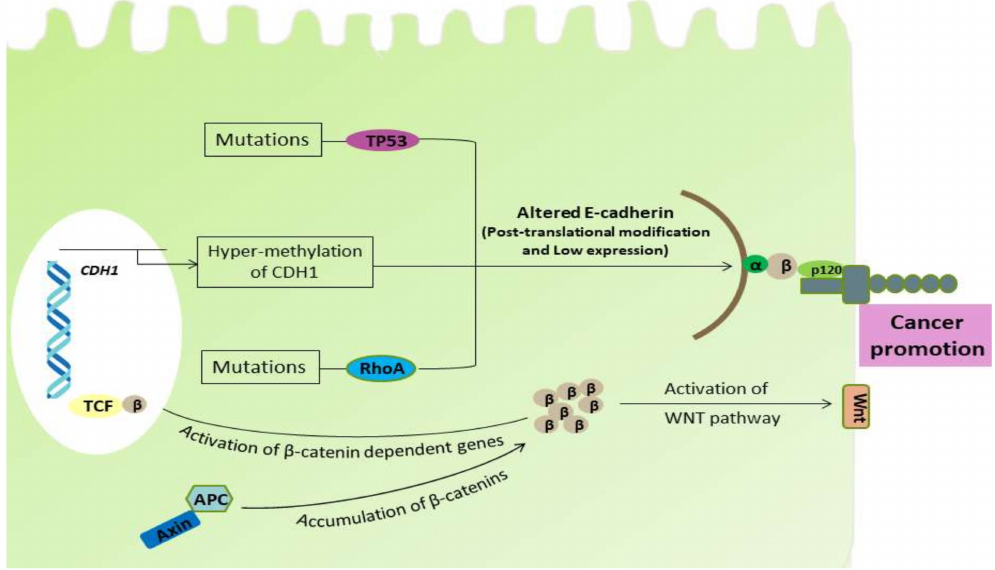
Figure 2. Pathogenicity and factors associated with the disruption of the normal cellular activity. Hyper-methylation of the CDH1 gene and mutational alteration in TP53 protein causes the impaired synthesis of E-cadherin. The truncated APC causes accumulation of β -catenin, which activates the β -catenin-dependent genes and Wnt pathway, altering normal cellular functions. The Wnt pathway after its activation causes the accumulation of β -catenins in cytoplasm and its translocation into the nucleus where it transcriptionally activates the transcription factors belonging to the TCF